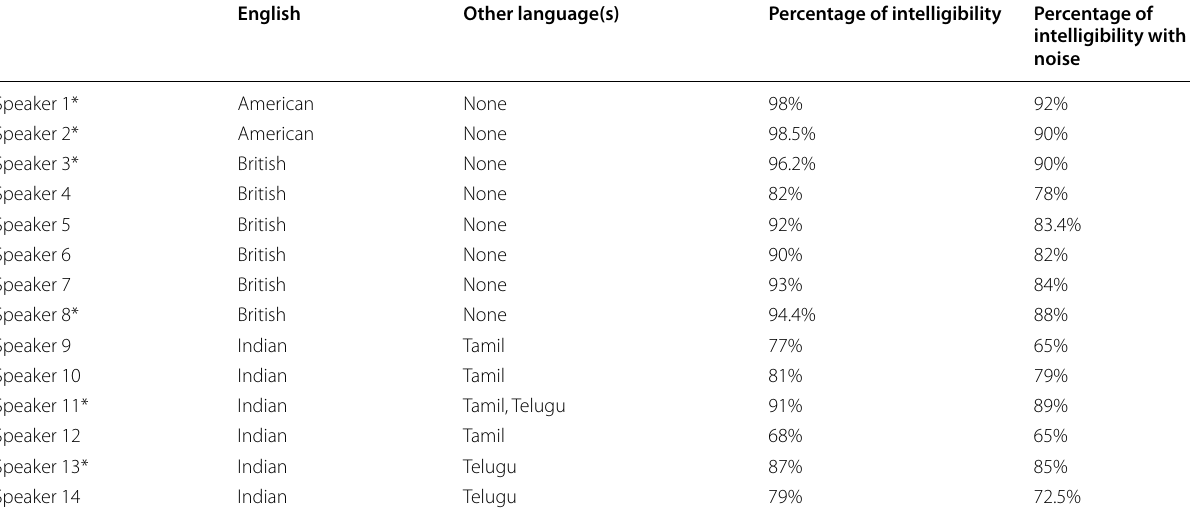
10) and without noise (n 14) for each American English, British English and Indian = =